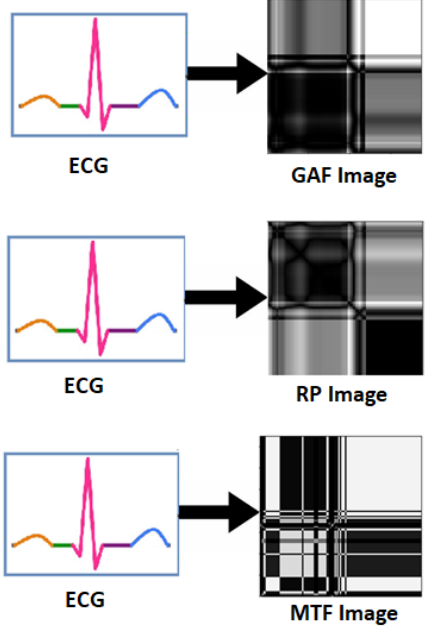
Figure 8. Transformation of ECG signal into GAF, RP and MTF